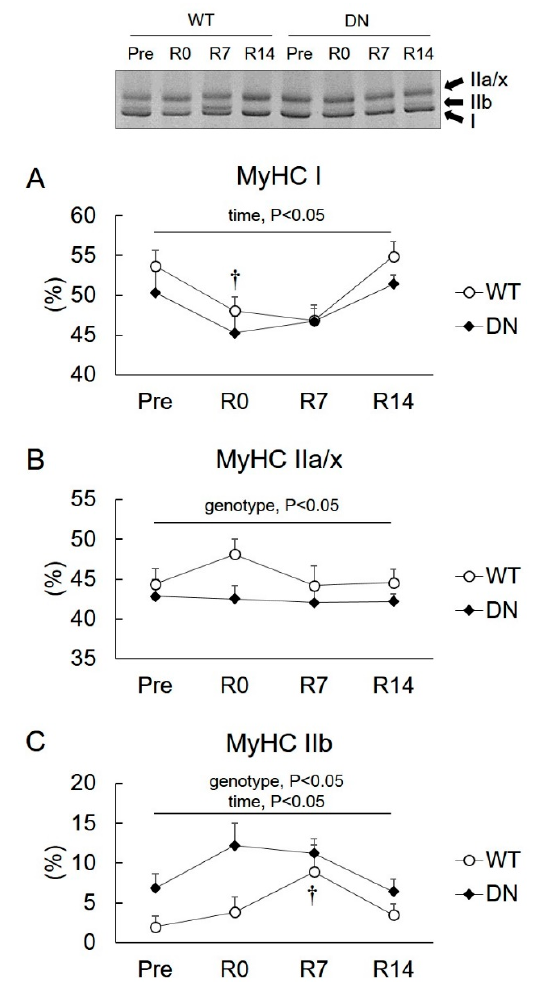
Figure 4. Changes in relative levels of myosin heavy chain (MyHC) isoforms in the soleus muscles after 14 days of hindlimb unloading, and at 0, 7, and 14 days of reloading. ( A ) MyHC I. ( B ) MyHC IIa/x. ( C ) MyHC IIb. Representative image is shown. Values are means ± SE; n = 8 per group. Statistical results of two-way ANOVA (genotype, time, and genotype × time) are described in the Figure. †, significant difference from Pre independent of genotype.